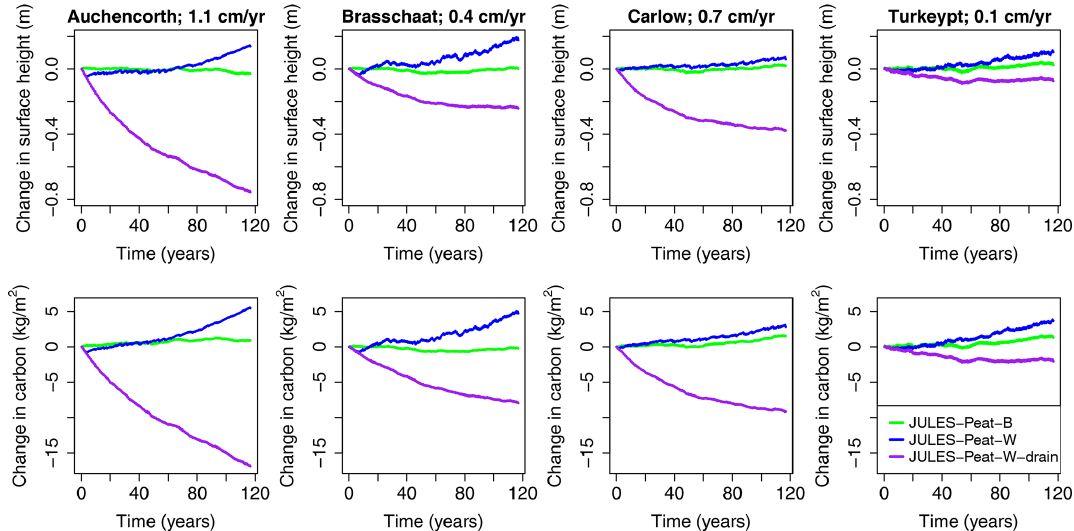
Figure 8. Carbon and surface height dynamics following drainage: JULES-Peat-W and JULES-Peat-W-drain are both spun up with a wet soil column, but JULES-Peat-W-drain has lateral flows switched back on at the start of the historical simulation, which is shown here. JULES- Peat-B is also shown for comparison, showing that carbon does not accumulate at these sites to the extent that it does when the sites are wet (compare JULES-Peat-B to JULES-Peat-W). Subsidence rates (in cmyr − 1 ) over the first 40 years are indicated in the panel labels. Water table depth in each simulation is given in Table 4. Table 4. Median water tables corresponding to the simulations shown in Fig. 8. Water table depth